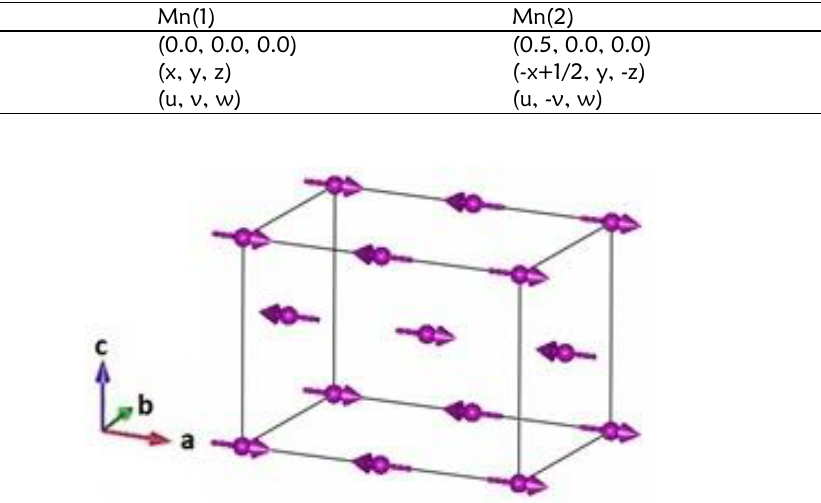
Figure 6. The antiferromagnetic structure of LaMnO 3 .